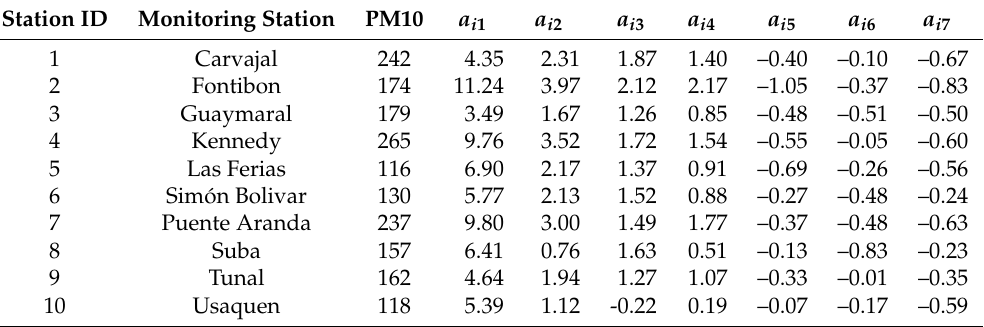
Figure 1. Spatial location of ten air quality monitoring stations in the Bogotá area. Circles are proportional to maximum PM10 values (maximum at each station was calculated based on data that were collected hourly between 26 January 2011 at 12:00 p.m. to 3 February 2011 at 2:00 p.m.). Table 1. PM10 values and coefficients a ij , for i = 1, . . . , n and j = 1, . . . ,7, of Fourier basis functions fitted to SW data (collected each two hours between 26 January 2011 and 3 February 2011 at each of ten environmental monitoring stations in Bogotá,